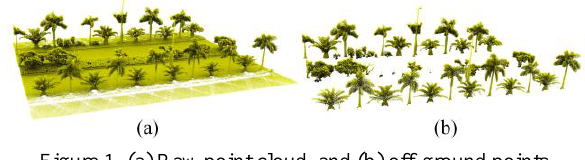
Figure 1. (a) Raw point cloud, and (b) off-ground points.